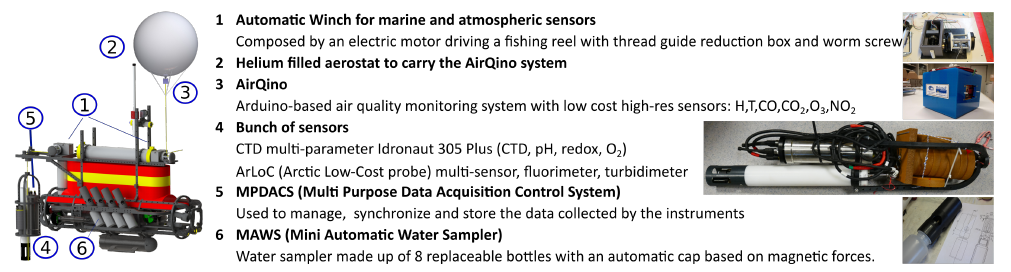
Figure 23. PROTEUS-USSV configuration in the Svalbard 2018